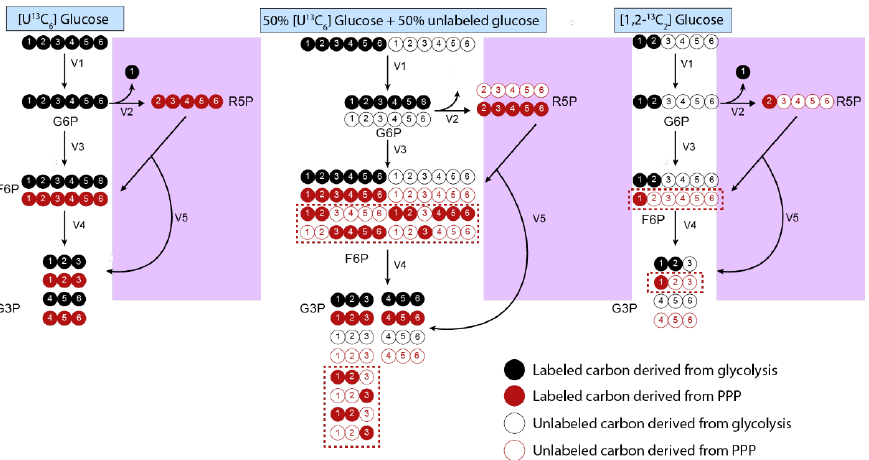
Figure 4. Tracer compositions should be scrutinized to optimize information for pathways of interest. The example displays a simple glycolytic pathway in which we assume that reactions only flow in the forward direction. Uniformly labeled glucose results in identical isotopomers from the PPP (purple box) and glycolysis. Using a combination of 50% fully labeled glucose with 50% unlabeled glucose can better inform PPP fluxes, as the complex atom rearrangement in the PPP leads to M+1, M+2, M+4, and M+5 isotopomers (shown in red box). The percent composition of these isotopomers can be used to determine flux activity at the PPP branchpoints. A more direct option is to use [1,2- 13 C 2 ] glucose, which generates an M+1 isotopomer after entering the PPP by being metabolizing into R5P that is further metabolized into M+1 F6P and G3P. In contrast, the glucose that is directly metabolized into F6P generates M+2 isotopomers. Therefore, the ratio of M+1 and M+2 isotopomers in metabolites such as F6P and G3P, as well as derivatives such as lactate and pyruvate, can be compared to determine relative activity at the PPP branchpoint. Red = carbons that pass through the PPP; black = carbons that pass through the main glycolytic pathway. The red, dashed boxed encompasses isotopomers that can only be formed after passing through the PPP. Abbreviations: glucose-6-phosphate (G6P), ribose-5-phosphate (R5P), fructose-6-phosphate (F6P), glyceraldehyde-3-phosphate (G3P), pentose phosphate pathway